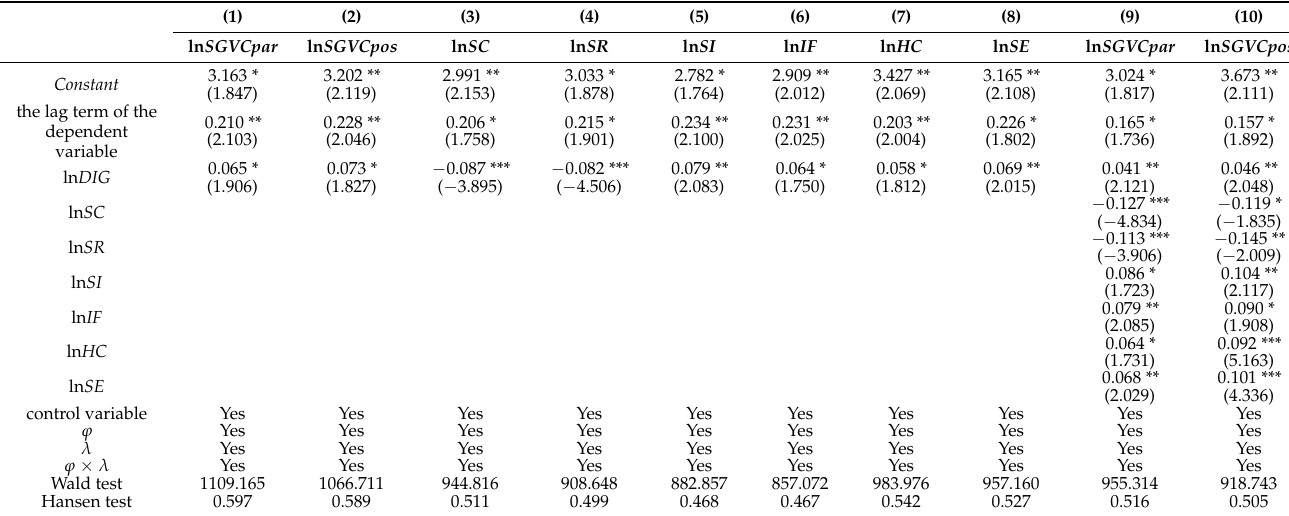
Table 7. Results of mediation